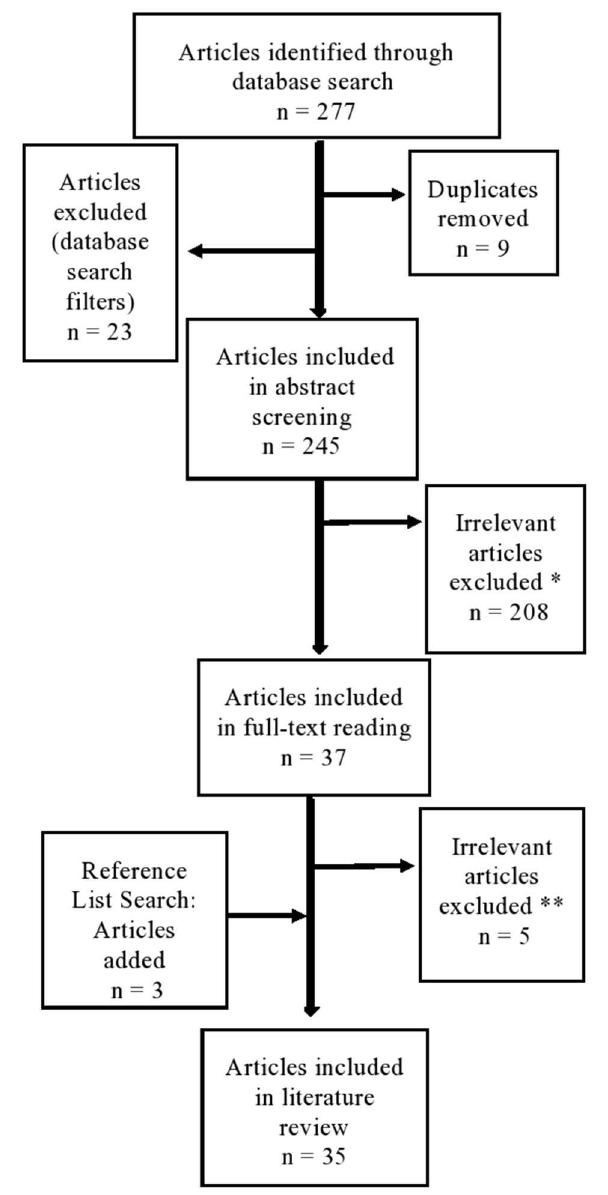
FIGURE 1 | Article search and selection process. *Reason for exclusion: not in higher education; **Reason for exclusion: did not meet all eligible criteria.